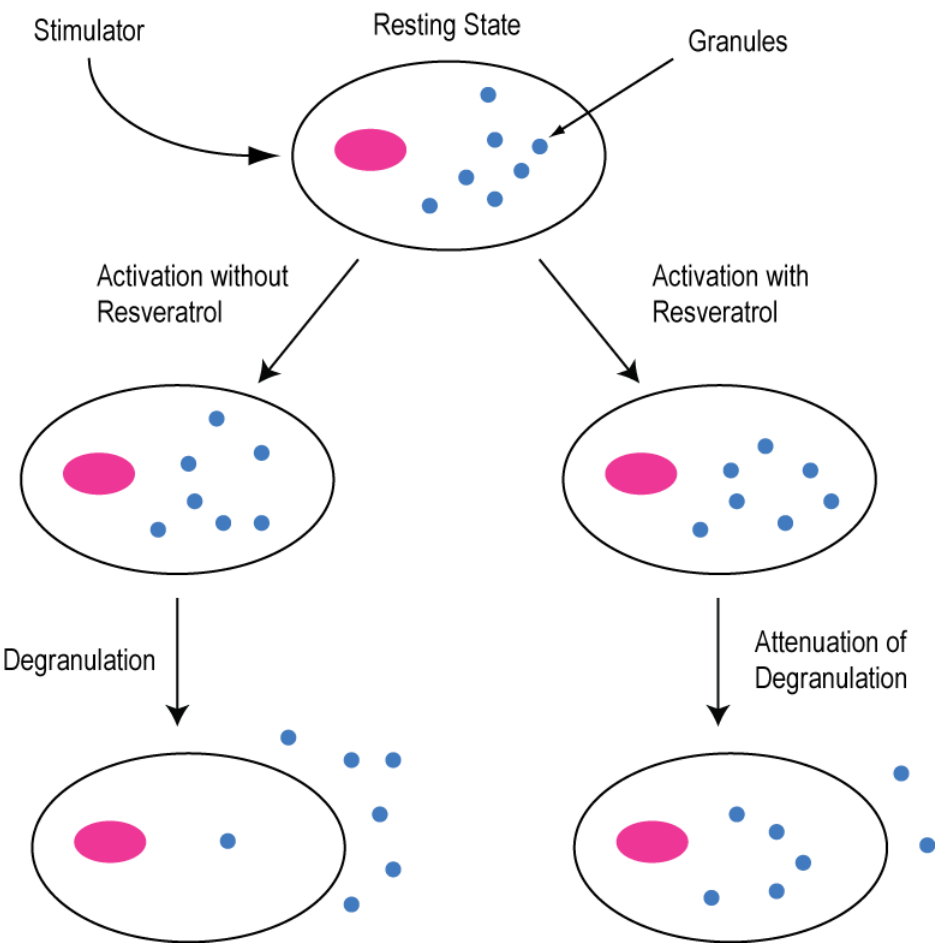
Figure 2. Resveratrol attenuates immune responses related to degranulation